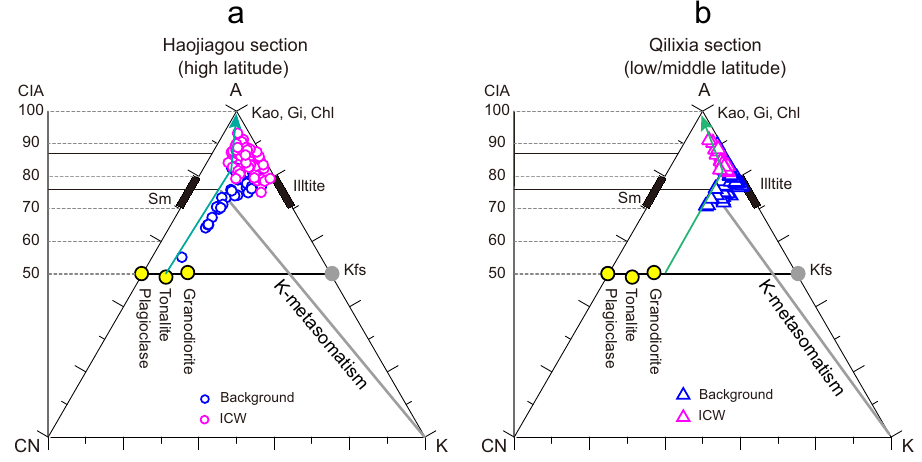
Fig. 4 Ternary diagrams of A-CN-K for the Haojiagou. ( a ) and Qilixia ( b ) sections. Purple and blue symbols represent samples from intensely chemically weathered (ICW) and background intervals, respectively. The green arrows represent weathering trends. A = Al 2 O 3 , CN = CaO* + Na 2 O, K = K 2 O; Chl chlorite, Gi gibbsite, Kao kaolinite, Kfs K-feldspar, Sm smectite. Other details as in Supplementary Figs. 2 and 3. Source data are provided as a Source Data fi